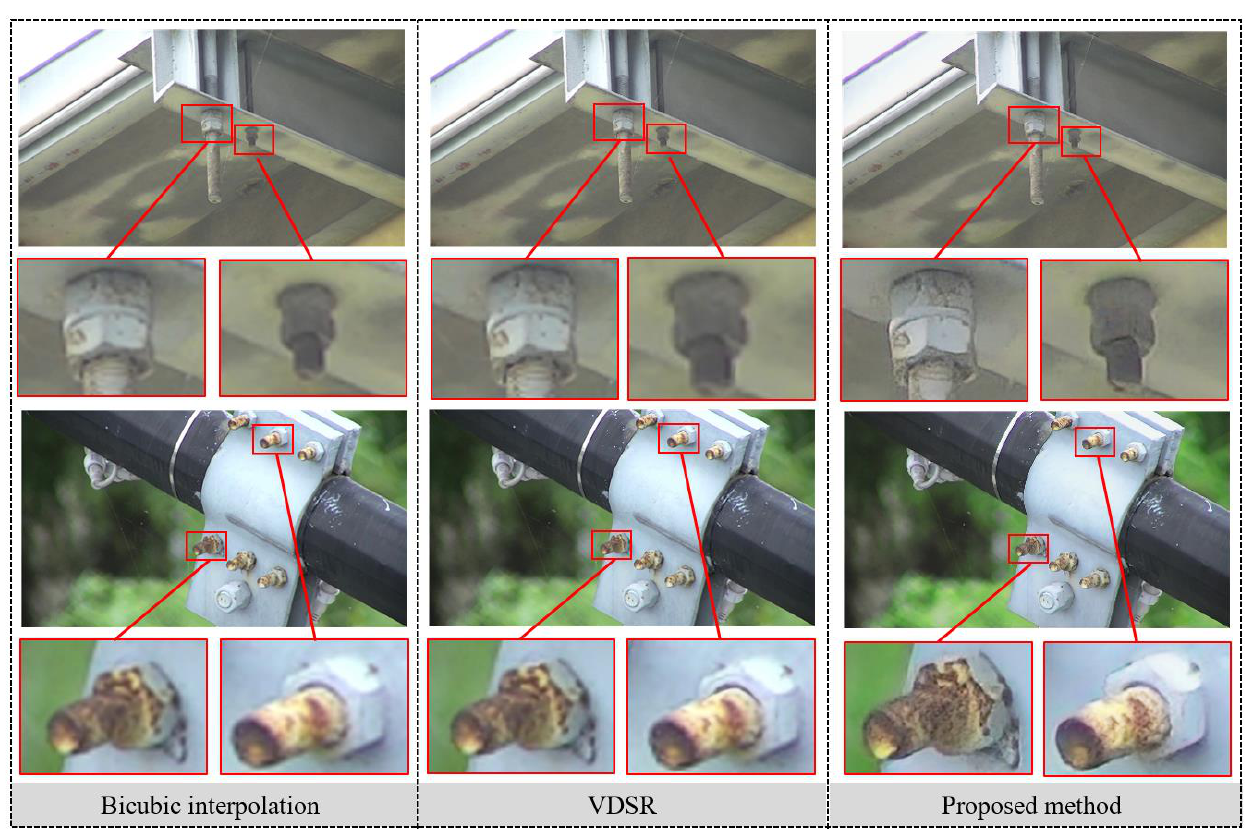
Figure 7. Comparison of super-resolution results using bicubic interpolation ( left ), VDSR ( middle ), and the proposed method ( right ).